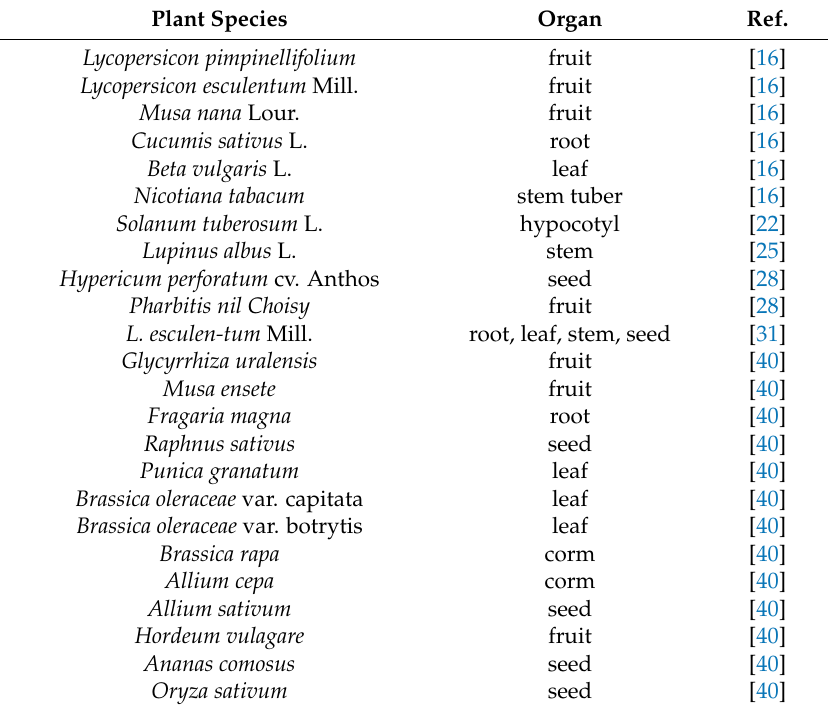
Table 1. Distribution of melatonin in plants and